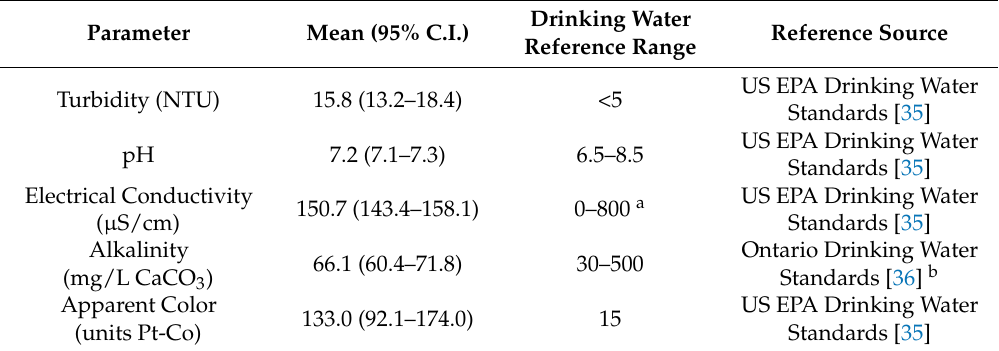
Table 3. Raw water quality of surface water source during August–September 2017 at the Palorinya SWTP (data taken from SWTP monitoring records).